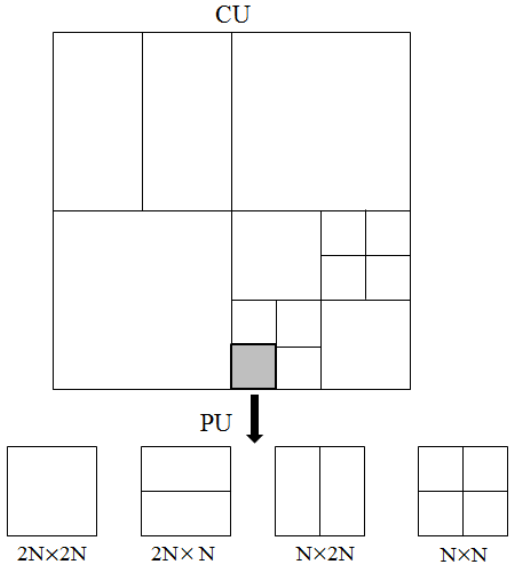
Figure 1. Figure 1. Example of coding units (CUs) and prediction units (PUs) in high efficiency video coding (HEVC).